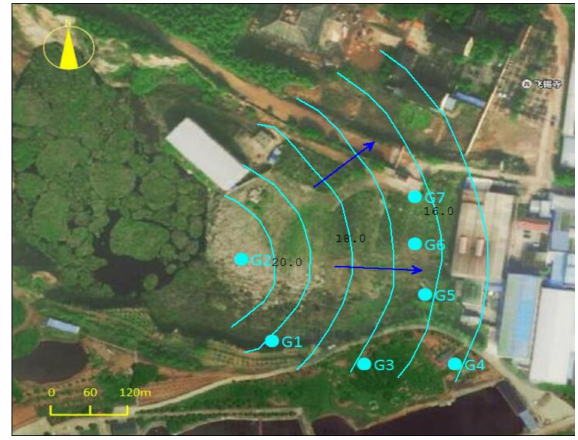
Figure 4. Water level in a contour map of the